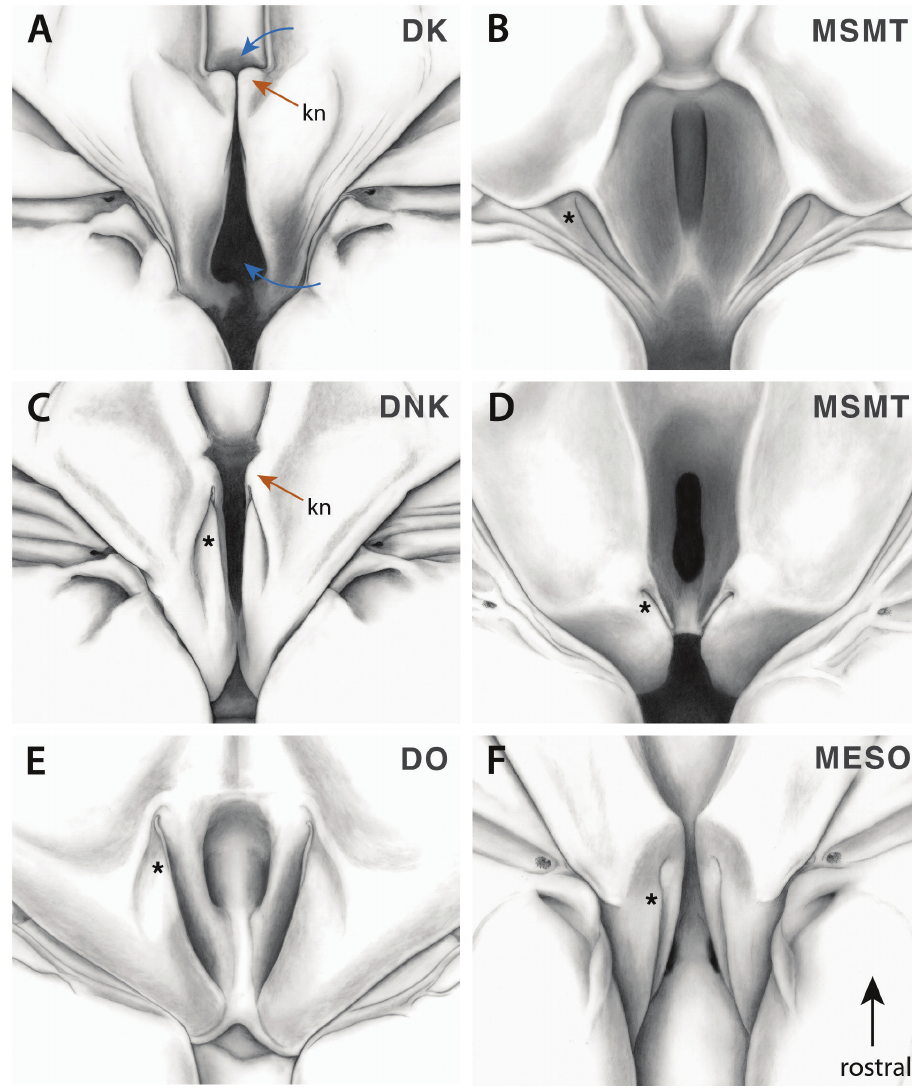
Figure 9. Annotated illustrations of hearing organ forms. Figures reproduced and adapted from Yager and Svenson (2008). A Parasphendale agrionina Gerstaecker, 1869 ♂ DK form hearing organ B Man- toida sp. ♀ MSMT form hearing organ C Parasphendale agrionina ♀ DNK form hearing organ D Angela Serville, 1839 ♂ MSMT form hearing organ E Tarachodes afzelii (Stål, 1871) ♀ DO form hearing organ F Hymenopus coronatus ♀ MESO form hearing organ. Asterisks indicate the ventral rod ( B – F ), which is not visible in the DK form (see Yager and Svenson 2008). Orange arrows indicate the knob, present on DK and DNK forms, barely visible in DO forms, and not present in MSMT forms. Blue arrows indicate opening to the auditory chamber. Abbreviation: kn =